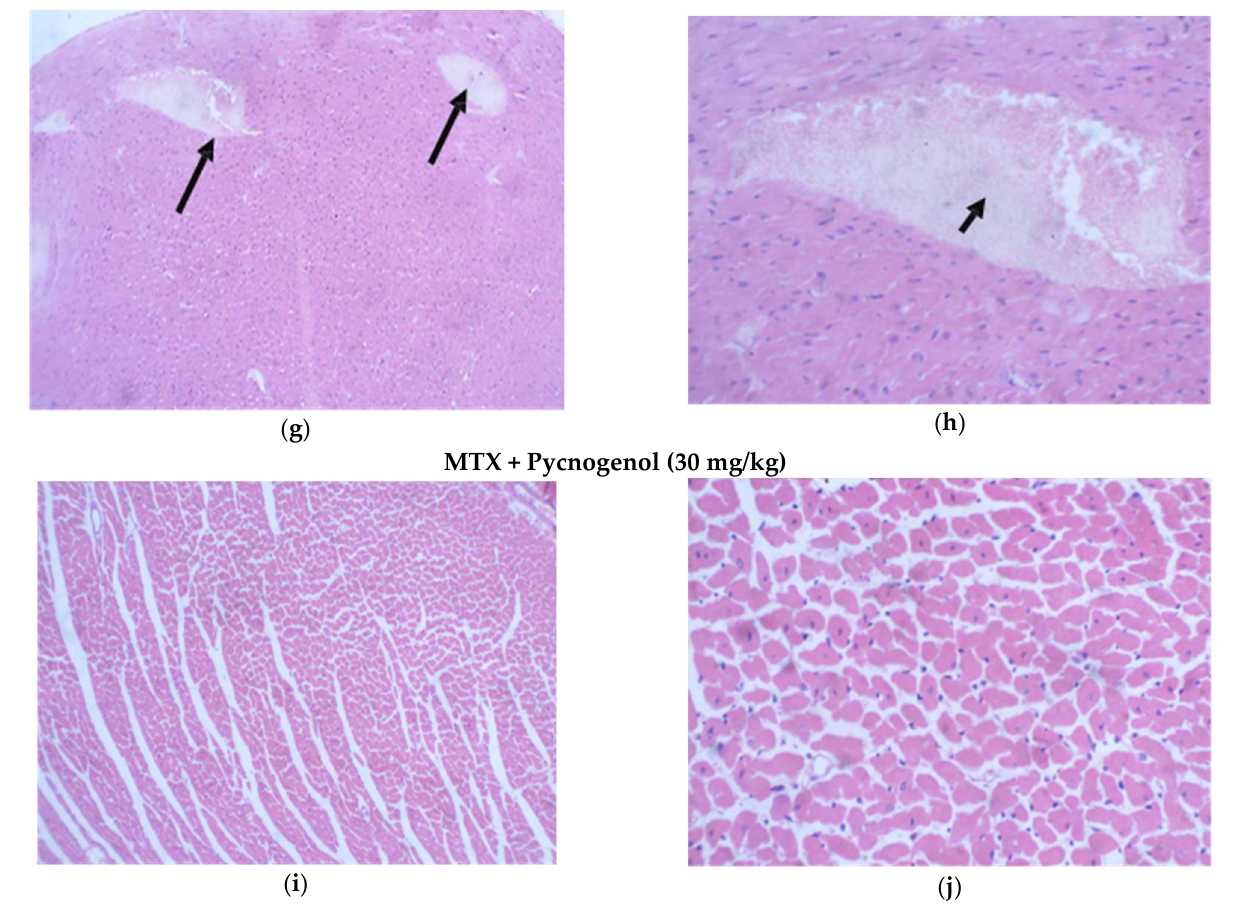
Figure 7. Photomicrograph of H&E-stained heart sections. ( a ) Normal heart muscle tissue (H&E, 10x). ( b ) Higher magnification of the previous figure showing uniform muscle bundles and cells (H&E, 40x). ( c ) An area of hemorrhagic myocyte necrosis representing about 20% (black arrow) muscle tissue (H&E, 10x). ( d ) Higher magnification of the previous figure showing area of hemorrhagic necrosis (black arrow), myocyte vacuolization (red arrows), and disappearance of nuclei in some myocytes (arrow heads). There is mild lymphocytic infiltrate (blue arrows) (H&E, 40x). ( e ) An area of hemorrhagic myocyte necrosis (black arrow) representing about 20% of muscle tissue (H&E, 10x). ( f ) Higher magnification of the previous figure showing an area of hemorrhagic necrosis (black arrows), myocyte vacuolization (red arrows), and disappearance of nuclei in some myocytes. There is mild lymphocytic infiltrate (blue arrows) (H&E, 40x). ( g ) Marked reduction in necrotic area, where scattered foci were evident (black arrows), representing less than 10% of muscle tissue (H&E, 10x). ( h ) Higher magnification of the previous figure showing the small area of hemorrhagic necrosis (black arrow), with no other signs of myocyte injury (H&E, 40x). ( i ) Restoration of normal heart muscle appearance (H&E, 10x). ( j ) Higher magnification of heart tissues showing no evidence of tissue injury (H&E, 40x).